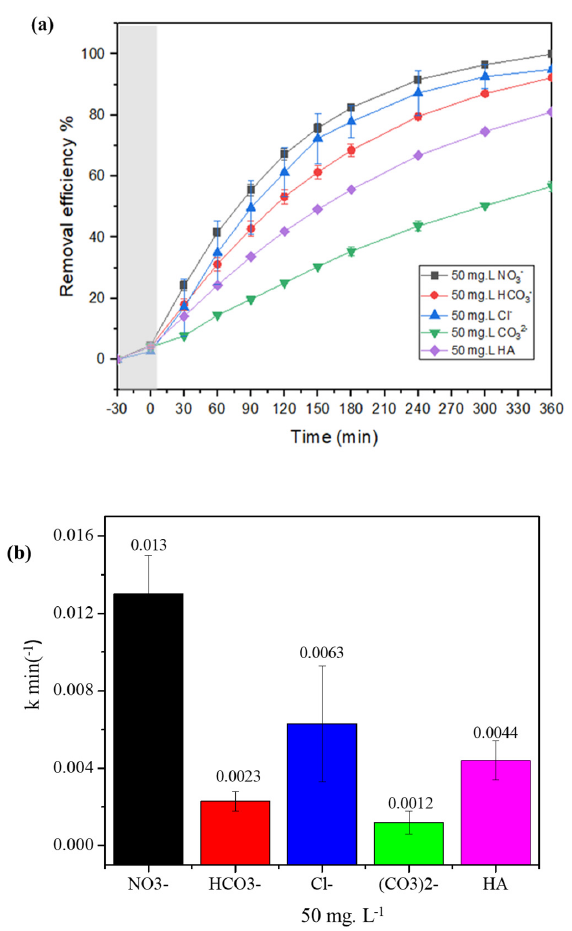
Figure 3. Degradation of CBZ with the addition of anions and HA: ( a ) Removal e ffi ciency; ( b ) kinetic degradation.